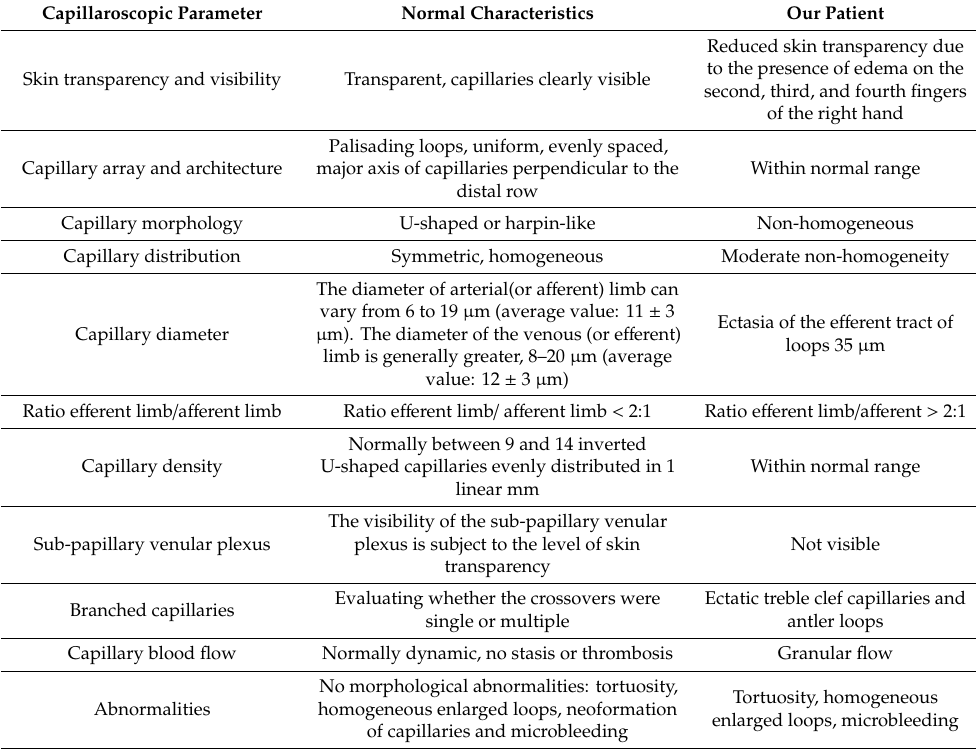
Table 1. Capillaroscopic Parameters normal characteristics and our patients